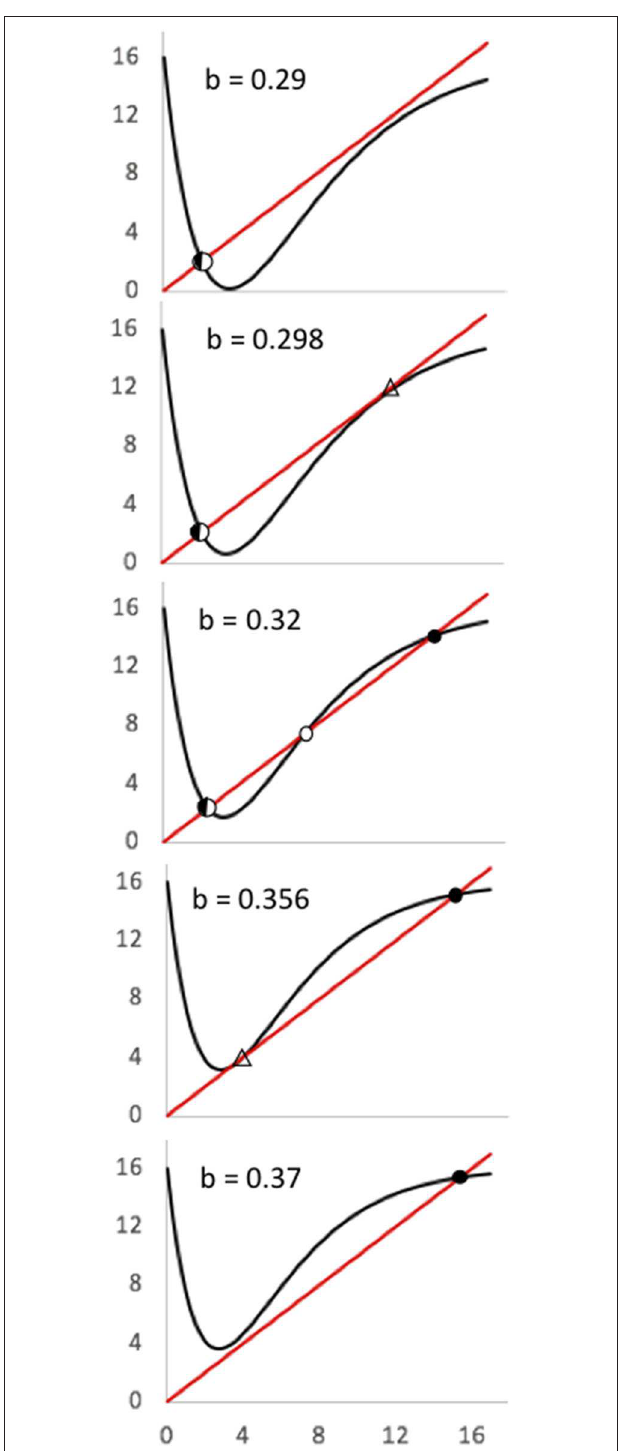
FIGURE 7 | Sequence of bifurcation of Equation (7) (K